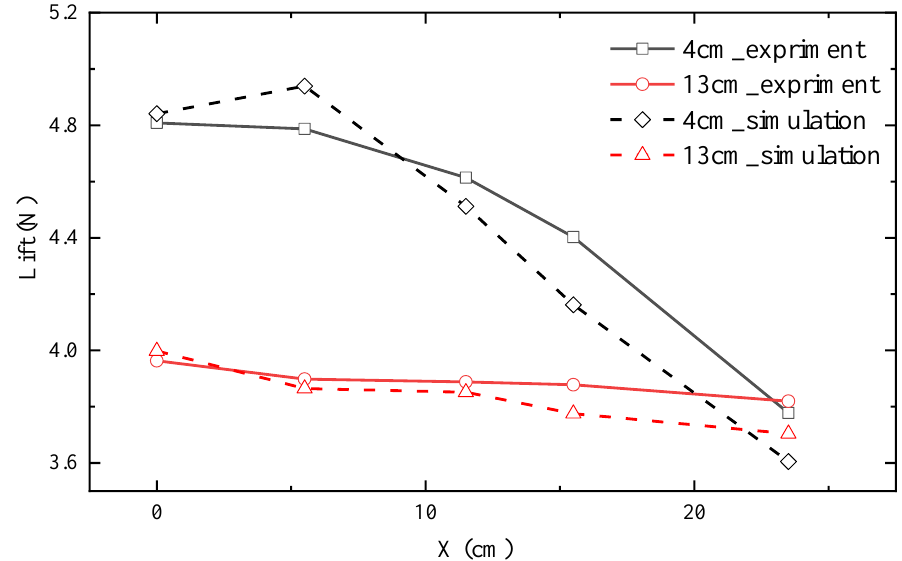
Figure 15. The lift of child UAV in body-outside transition area. Figure 15. the lift of child UAV in body-outside transition area. Figure 15. the lift of child UAV in body-outside transition area.